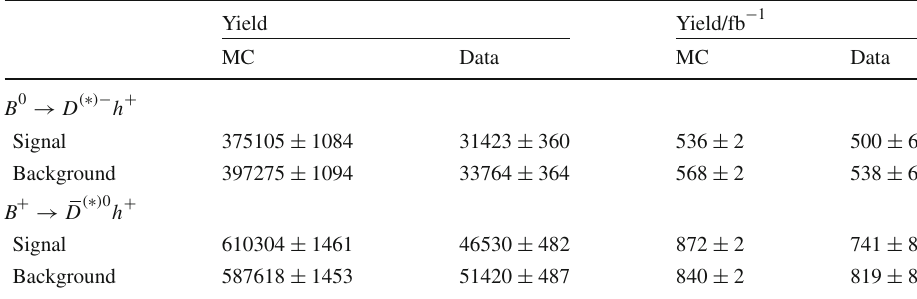
( ∗ ) + h candidates reconstructed in (left) simulation and (right) data,